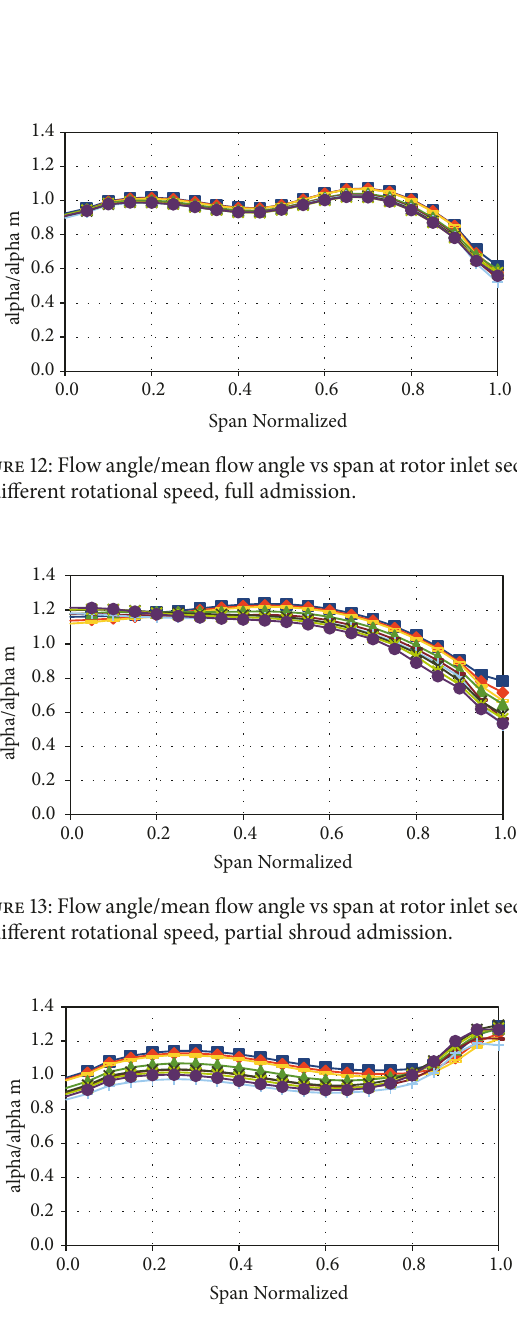
Figure 14: Flow angle/mean flow angle vs span at rotor inlet section for different rotational speed, partial hub